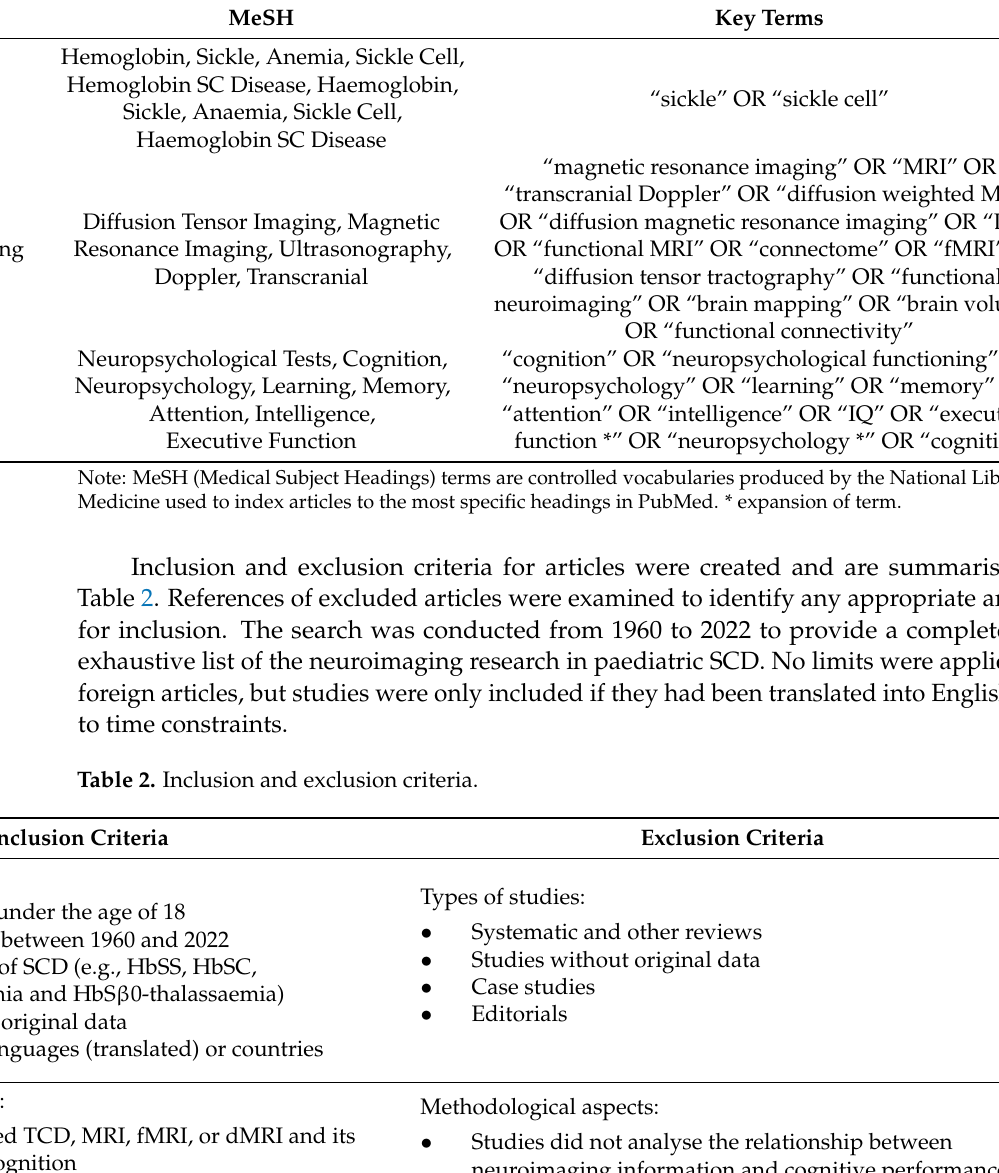
Table 1. Search strategy in PubMed.